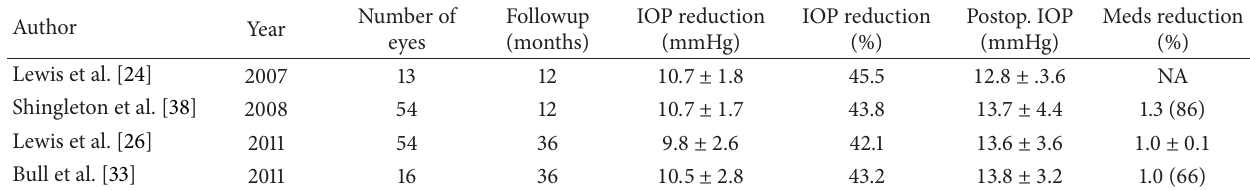
Table 8: Combined canaloplasty with phacoemulsification.